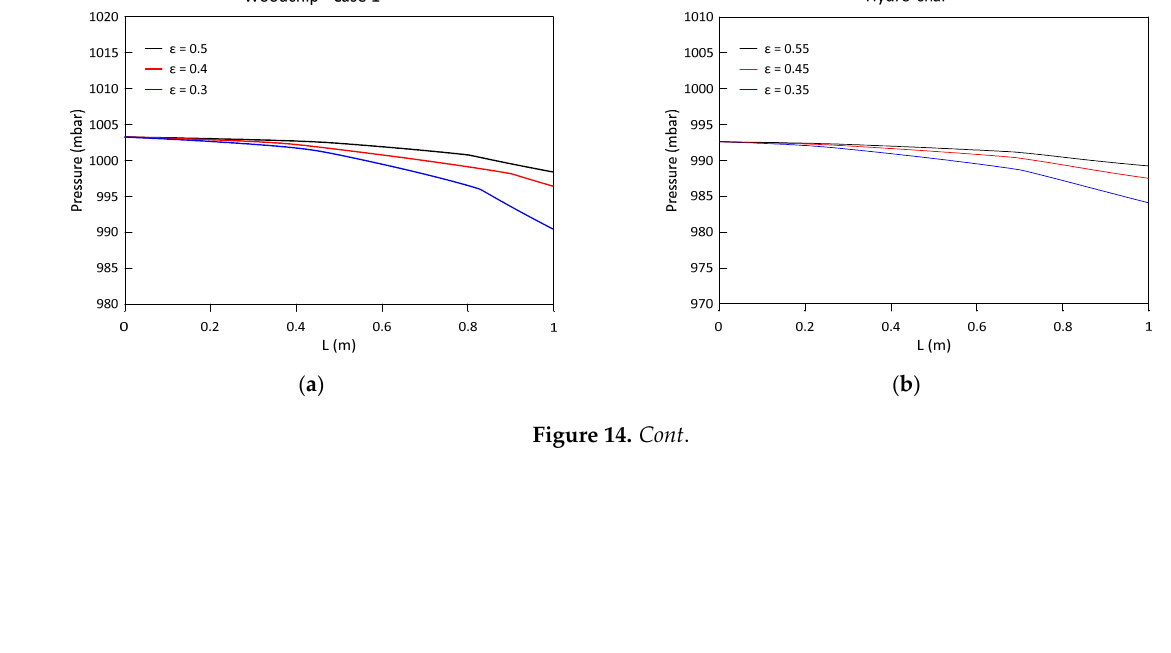
( c ) Figure 14. Pressure evolution along the reactor axis at different ε for ( a ) woodchip case 1, ( b ) hydro-char from green waste, ( c ) olive pomace.